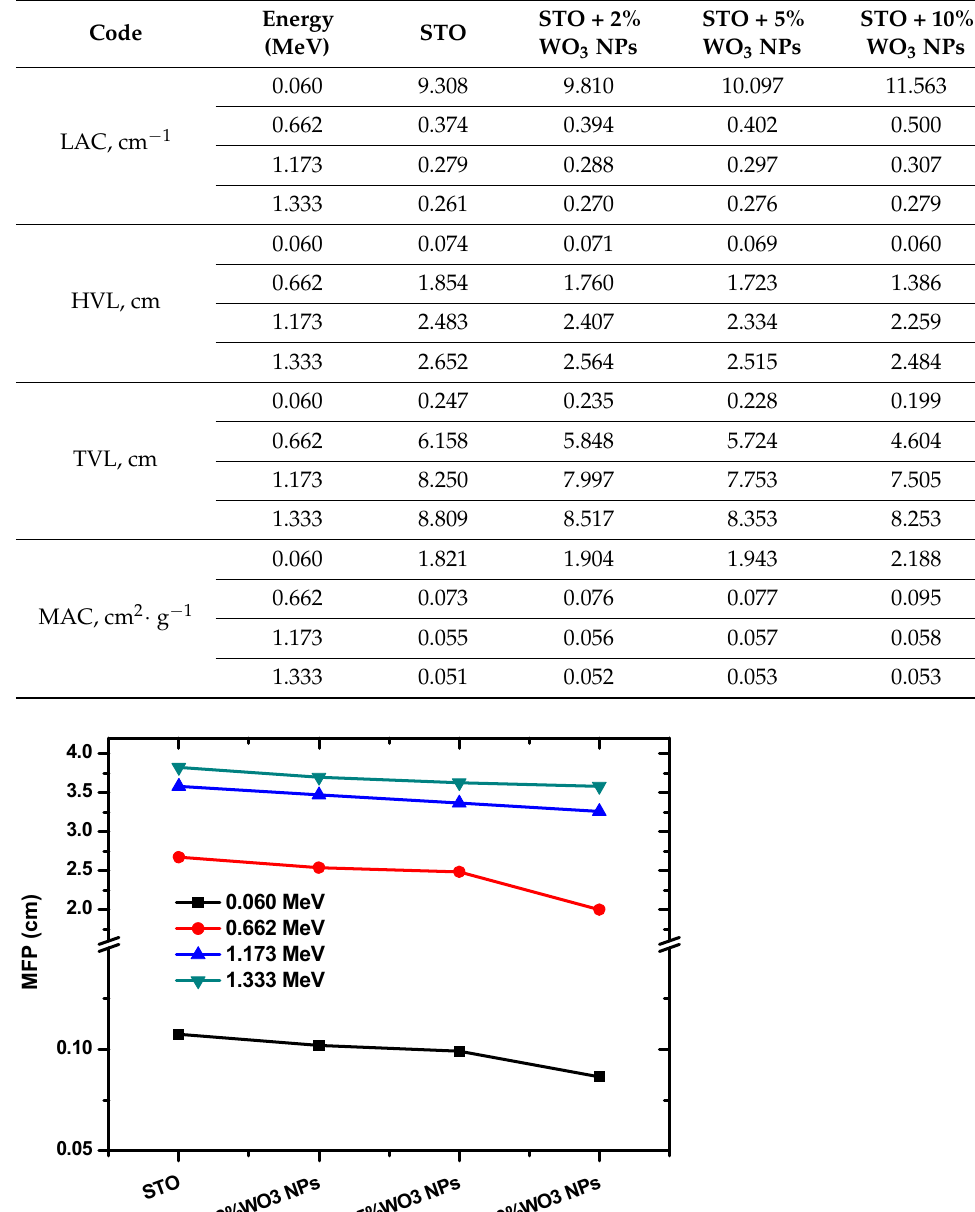
Table 2. The experimental values of the attenuator parameters for STO-ceramic samples.